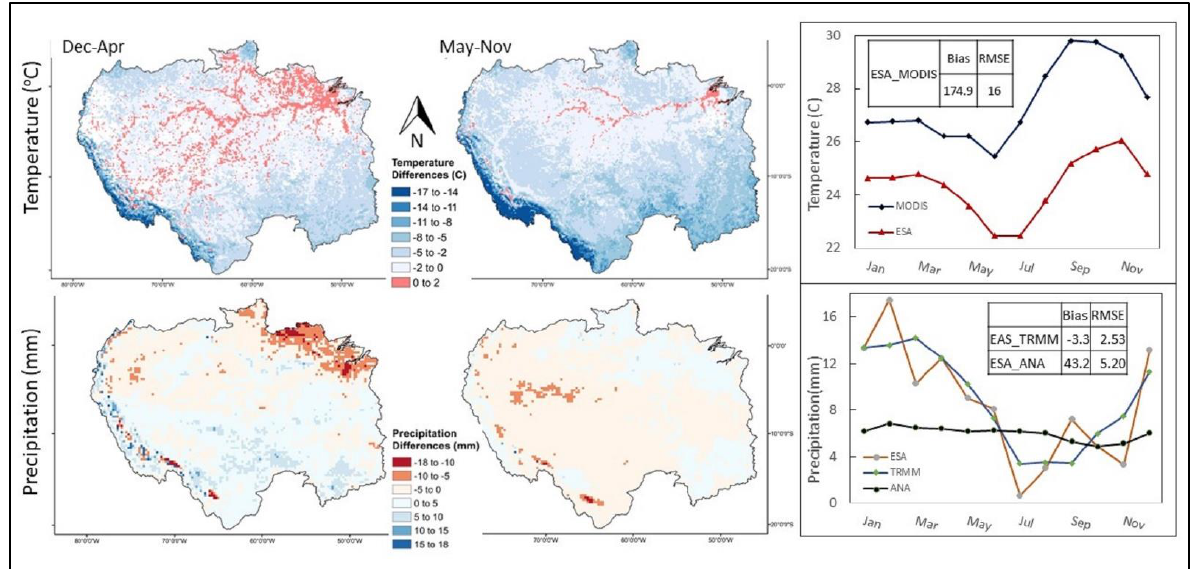
Figure 3. Difference maps between the simulated precipitation and simulated temperature, forced with reforested and current LCC on the left. On the right, the mean monthly temperature and precipitation (averaged over the basin) from observation and model output, along with the errors in the inset boxes.